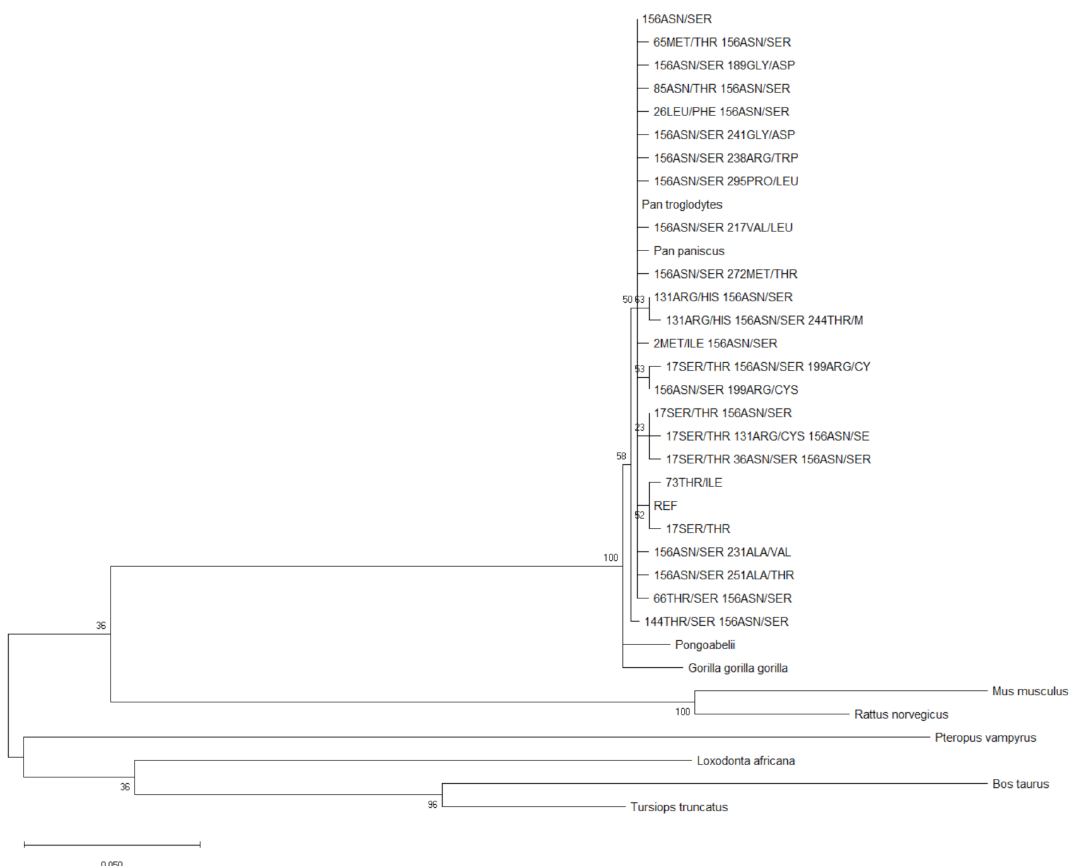
Figure 3. Molecular Phylogenetic analysis of the GLYAT haplotypes using the maximum likelihood method. The evolution- ary history was inferred by using the maximum likelihood method based on the Jones–Thornton–Taylor (JTT) matrix-based model [57]. The bootstrap consensus tree inferred from 500 replicates [59] is taken to represent the evolutionary history of the taxa analysed. Branches corresponding to partitions reproduced in less than 50% bootstrap replicates are collapsed. The percentage of replicate trees in which the associated taxa clustered together in the bootstrap test (500 replicates) is shown next to the branches. Initial tree(s) for the heuristic search were obtained automatically by applying Neighbour-Join (NJ) and Bio NJ algorithms to a matrix of pairwise distances estimated using a JTT model, and then selecting the topology with superior log likelihood value. A discrete Gamma distribution was used to model evolutionary rate differences among sites (five categories; + G , parameter = 2.7686). The analysis involved 34 amino acid sequences. All positions containing gaps and missing data were eliminated. There were a total of 296 positions in the final dataset. Evolutionary analyses were conducted in MEGA X